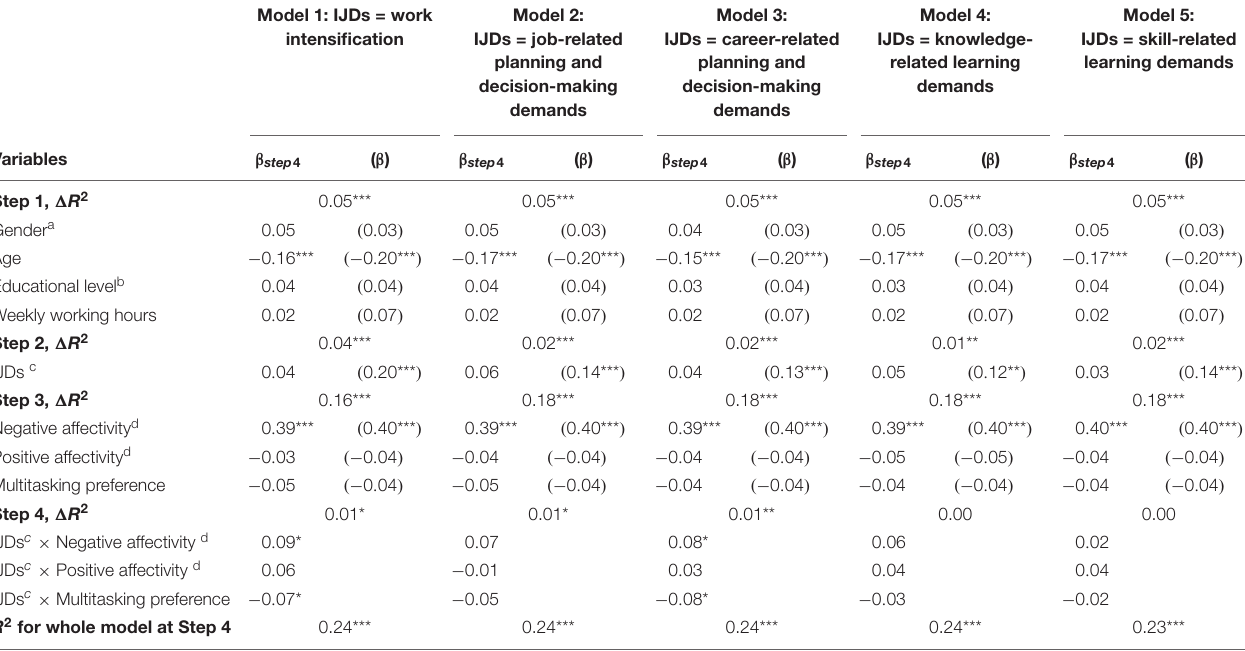
Model 1: IJDs = work Model 2: Model 3: intensification IJDs = job-related IJDs = career-related planning and decision-making